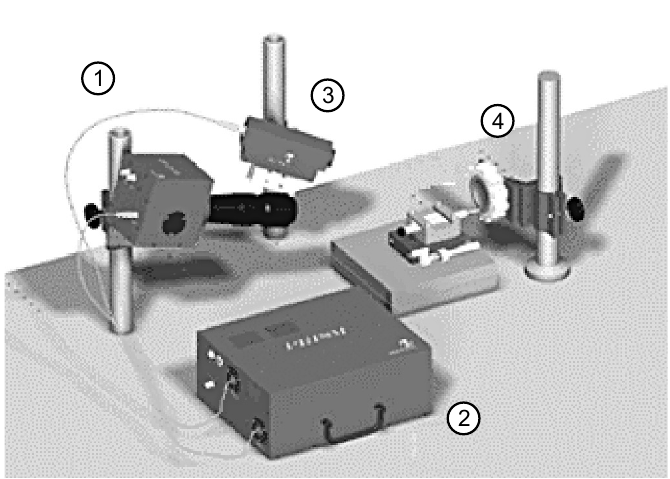
Figure 11. PRISMA system setup: (1) videohead; (2) control block; (3) illumination head of the object; (4) investigated object.